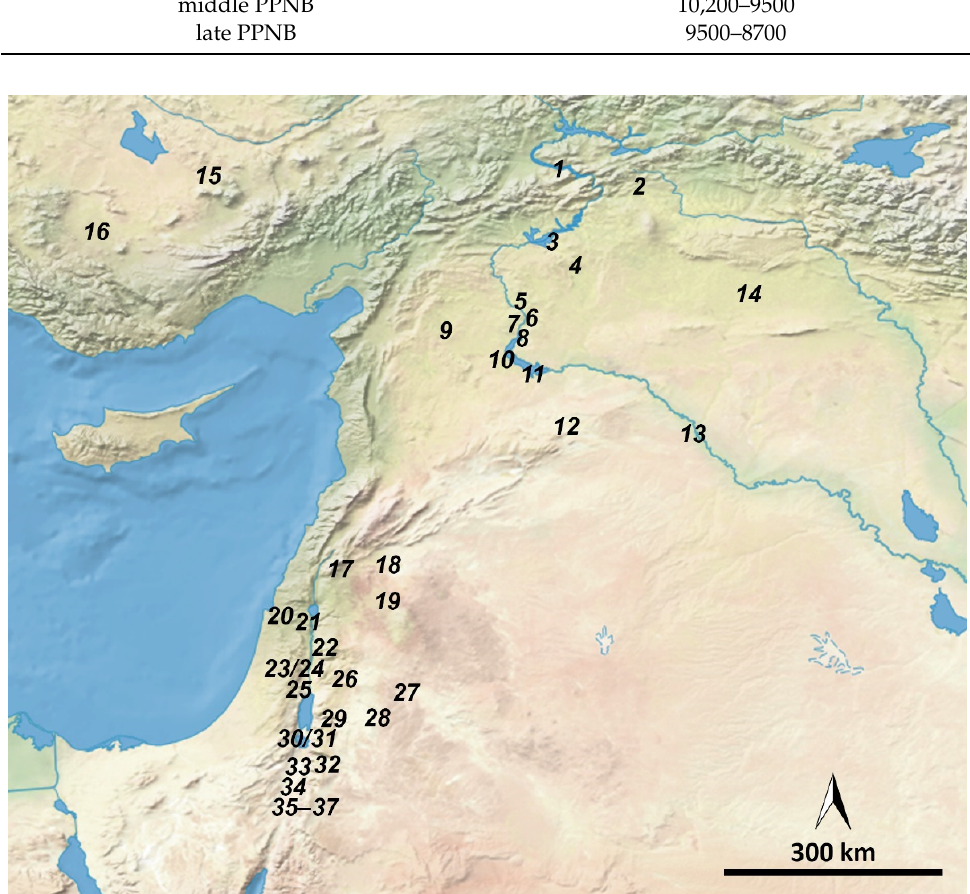
Figure 1. Distribution of PPN sites mentioned in the text. Key to sites: (1) Cafer Höyük, (2) Çayönü, (3) Neval ı Çor ı , (4) Göbekli Tepe, (5) Tell ‘Abr III, (6) Dja’de, (7) Tell Halula, (8) Jerf el Ahmar, (9) Tell Qaramel, (10) Tell Mureybet, (11) Tell Abu Hureyra, (12) El Kowm 2, (13) Tell Bouqras, (14) Seker al-Aheimar, (15) A ş ikl ı Höyük, (16) Çatalhöyük, (17) Tell Ramad, (18) Tell Aswad, (19) Tell Qarassa North, (20) Yiftahel, (21) Ohalo II, (22) Iraq ed-Dubb, (23) Gilgal I, (24) Netiv Hagdud, (25) Jericho, (26) ‘Ain Ghazal, (27) Azraq basin, (28) Wadi el-Jilat, (29) Es-Sifyia, (30) Dhra’, (31) ZAD 2, (32) el-Hemmeh, (33) Wadi Fidan, (34) Wadi Faynan, (35) Beidha, (36) Basta, (37) Ba’ja.